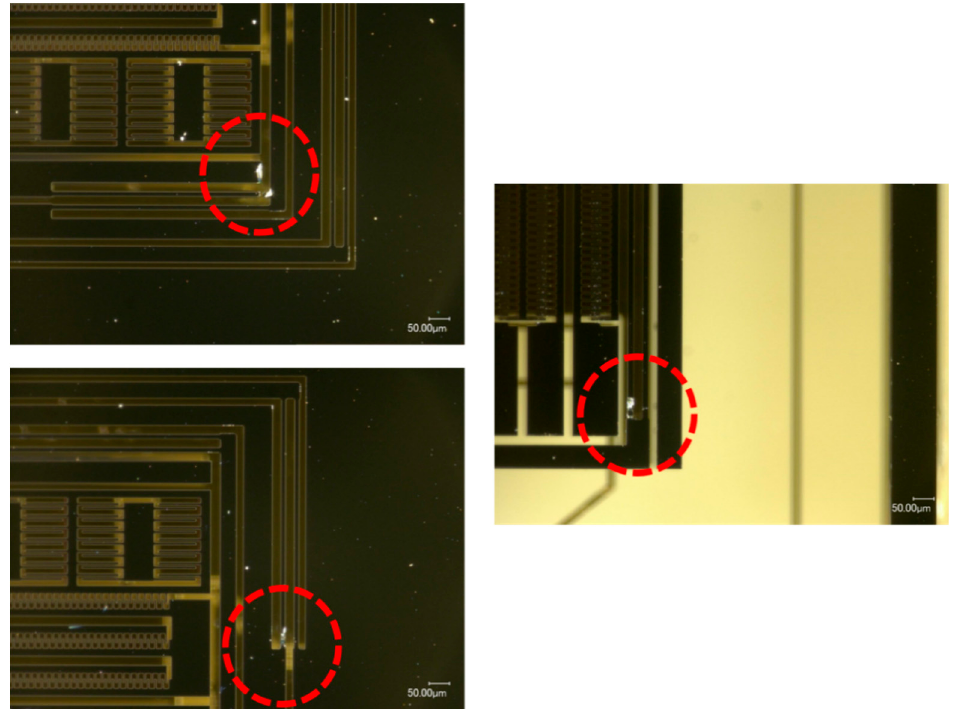
Figure 16. MEMS tuning fork gyroscope failures under positive Z-axis shock impact (a 0 = 20,000 g, τ = 80 µs).